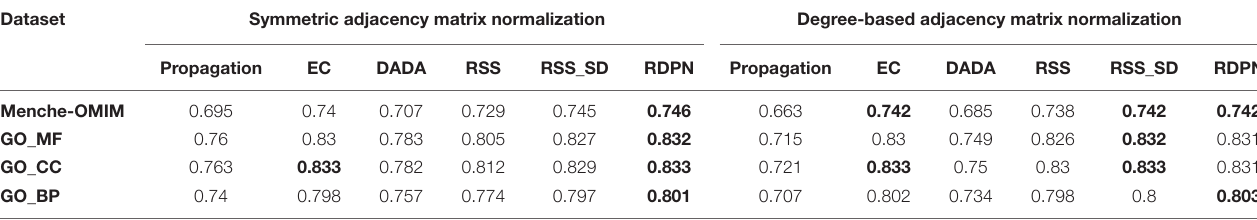
TABLE 1 | Average AUROC of the six methods across four data sets, using two variants of adjacency matrix normalization. Dataset